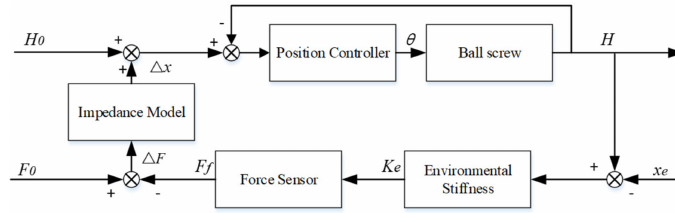
Figure 5. The system structure of force-controlled